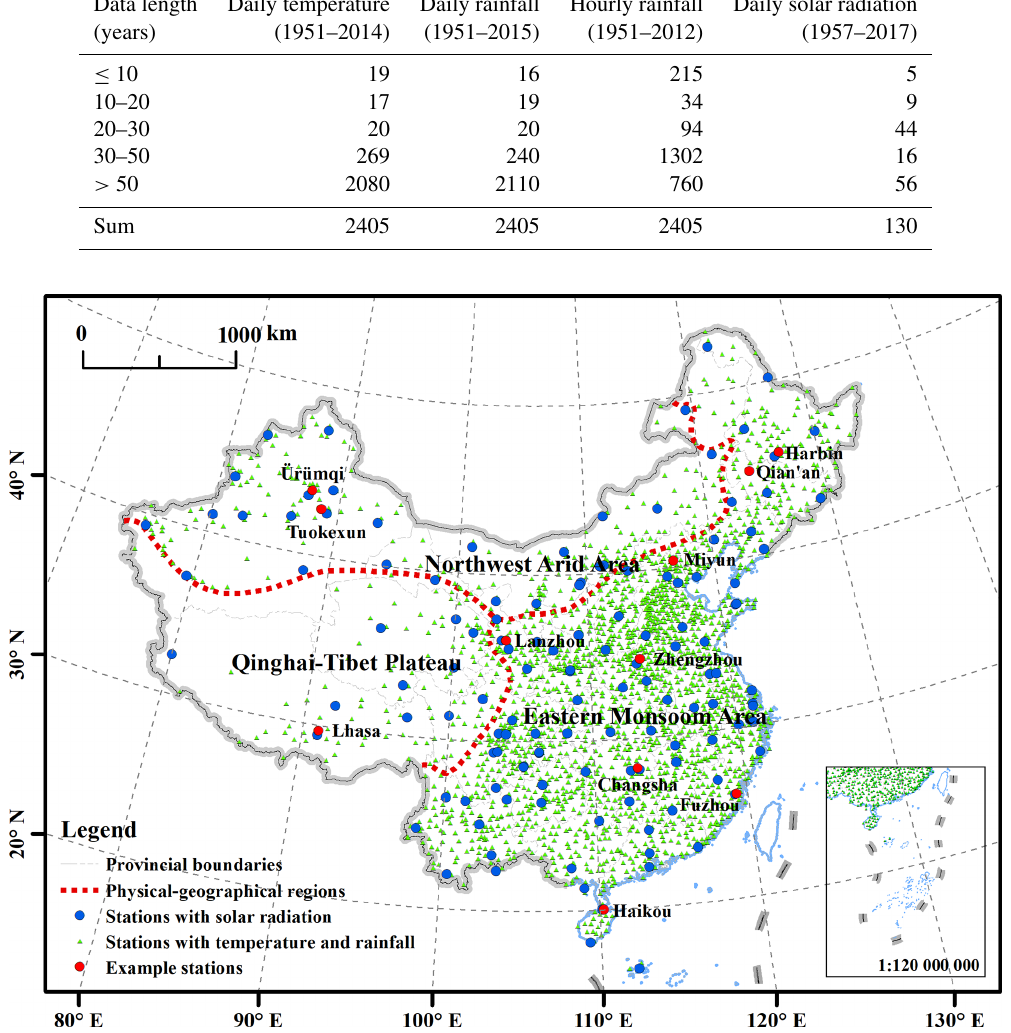
Figure 1. Map of the study area showing the locations of meteorological stations used in this study.